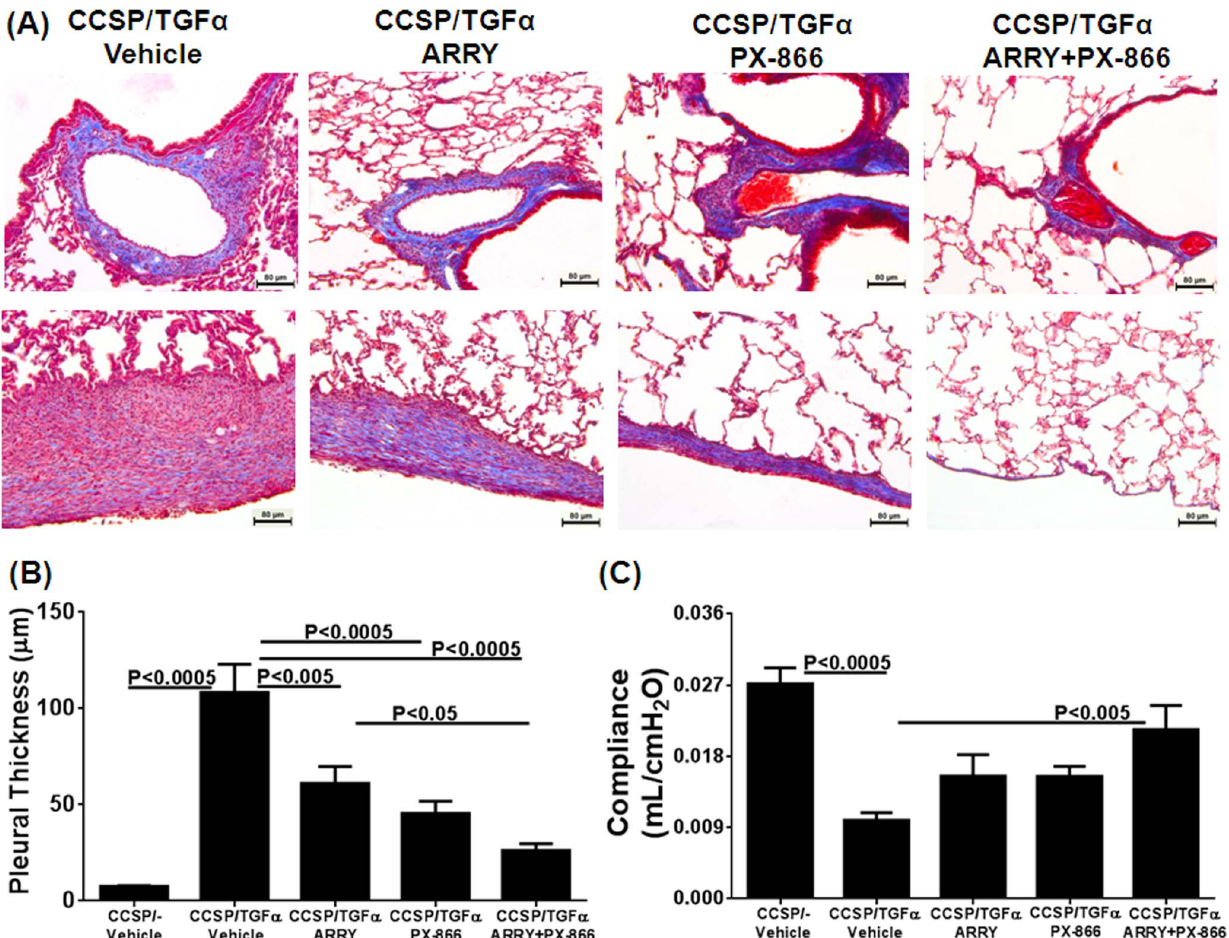
Figure 3. Inhibition of MEK and PI3K alone or in combination alters collagen accumulation and pleural thickening during TGF a - induced pulmonary fibrosis. (A) Representative photomicrographs of lung tissues stained with Masson Trichrome for each treatment group. Upper panel: area of airways, vessels, and parenchyma. Lower panel: pleural regions. Scale bar, 80 m m. (B) Pleural thickness of lung tissues stained with Masson Trichrome for treatment groups. (D) Inhibition of MEK and PI3K alone or in combination alters lung compliance during TGF a -induced pulmonary fibrosis. Data are means 6 SEM, and statistical significance between groups was measured using one-way ANNOVA (n=8–12/group).